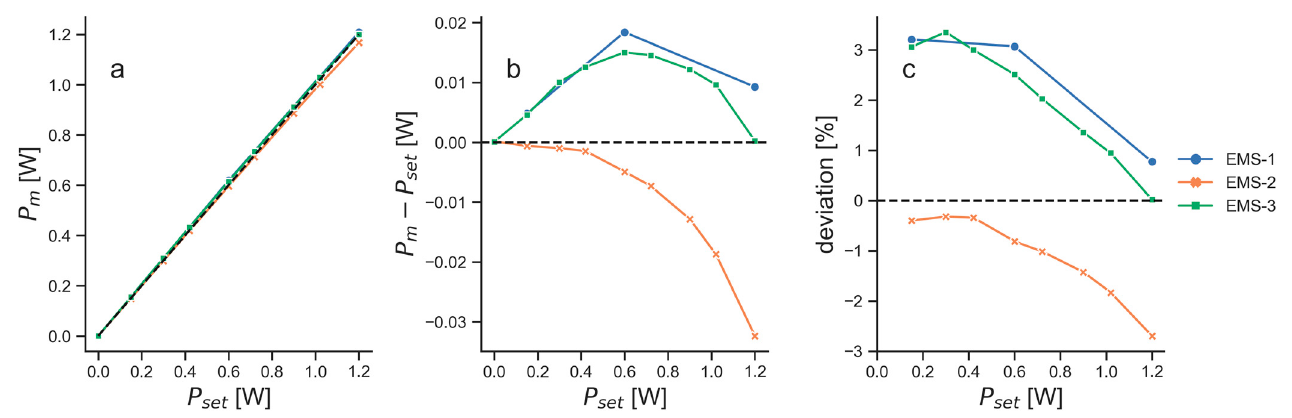
Figure 2. Power measurements of the three EMS lasers (EMS-1, blue dots and blue lines; EMS-2, orange dots and orange lines; EMS-3, green dots and green lines): ( a ) measured power ( P m ) for eight different powers set at the EMS laser units ( P set ); ( b ) the difference between P m and P set at each set power; ( c ) deviation of P m compared to P set as a percentage. Black dashed lines illustrate ideal curves where P m equals P set .